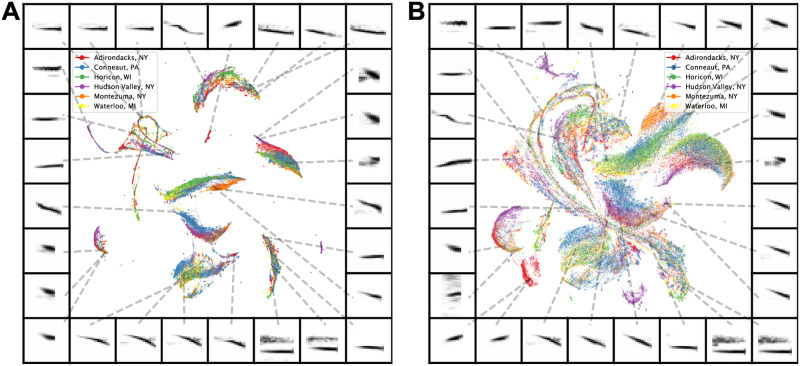
Comparing notes of swamp sparrow song across different geographic populations.(A) Notes of swamp sparrow song from six different geographical populations projected into a 2D UMAP feature space. (B) The same dataset from (A) projected into a 2D UMAP feature space where the parameter min_dist is set at 0.25 to visualize more spread in the projections.